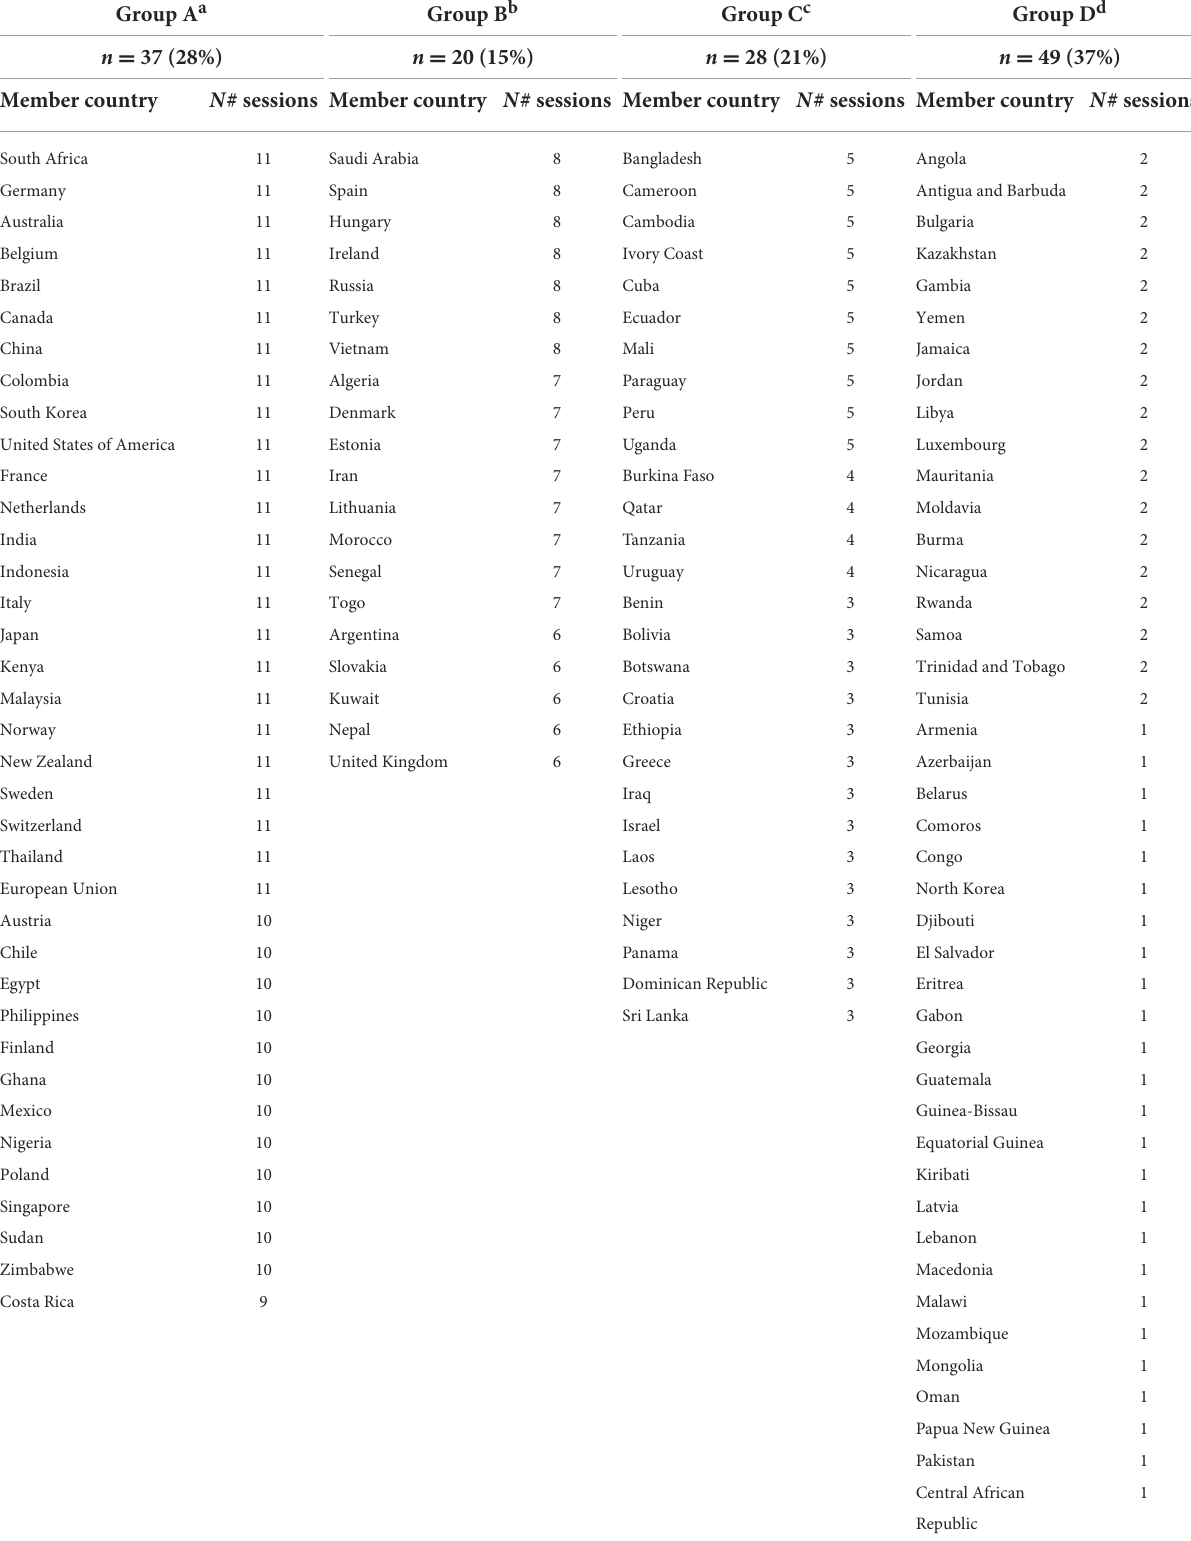
TABLE 3 Member countries attending CCNFSDU 1 according to number of sessions 2009–2019. Group A